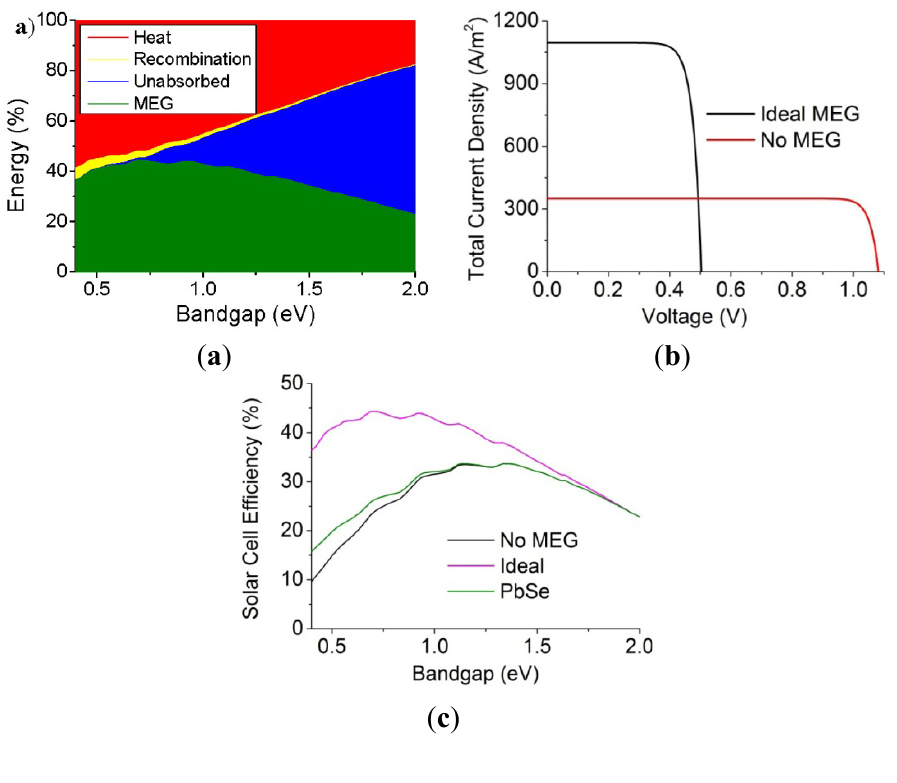
with g simulated using g , to the ideal case from th